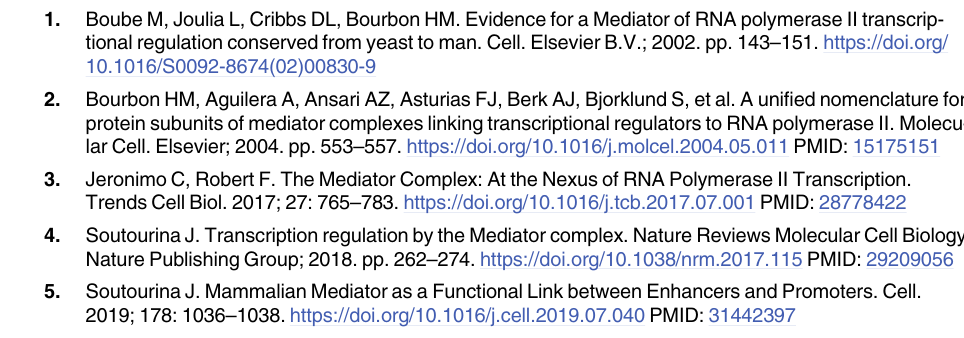
S3 Table. List of canonical housekeeping genes. S4 Table. Origin of HK, HK � , SR and SR � lists of genes. S5 Table. 30 best GO terms of the down-regulated genes sorted by FDR enrichment obtained on ShinyGO web